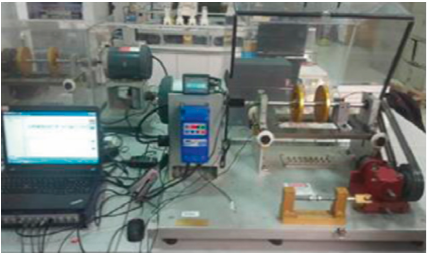
Figure 14: Bearing fault test